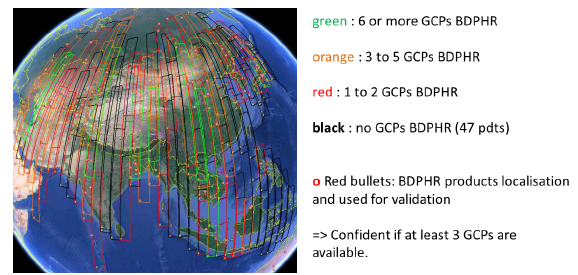
Figure 14. BDPHR number per Asia GRI products.